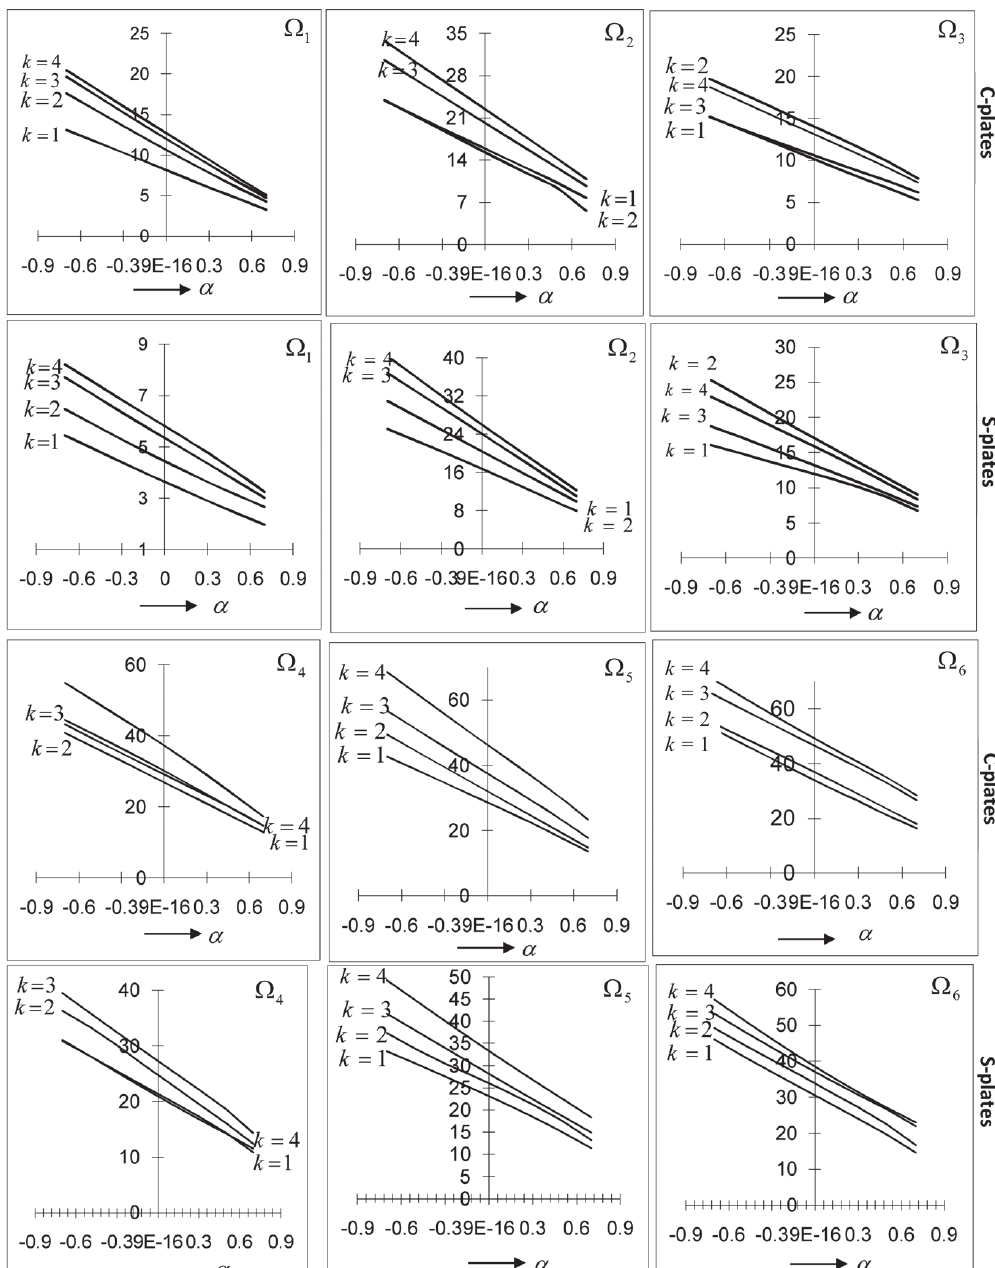
Fig. 3. Variation in Ω with α for corresponding C and S- plates when β = 0.7 and k = 1,2,3 and